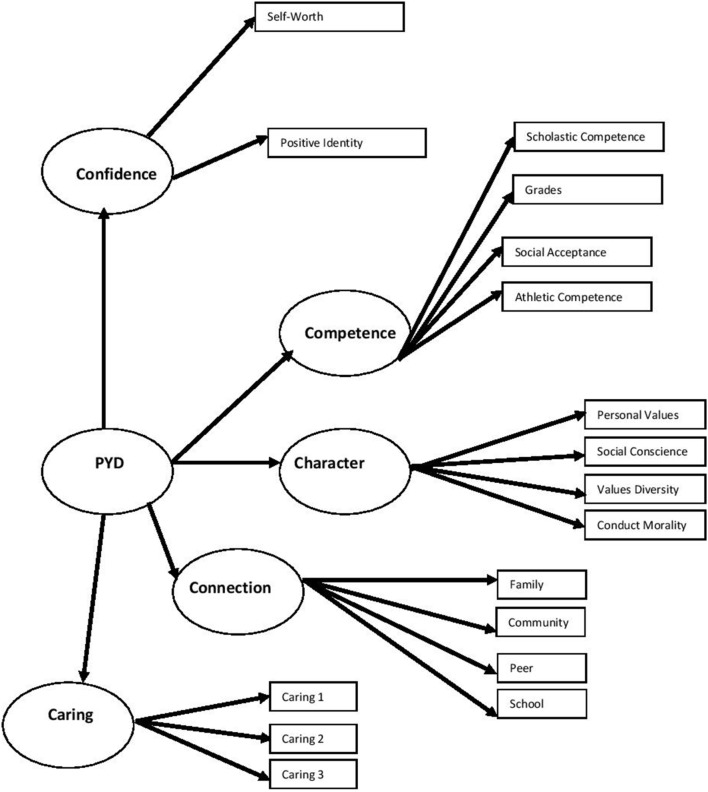
Five Cs model of positive youth development. PYD, positive youth development. Residual terms and covariances are omitted.